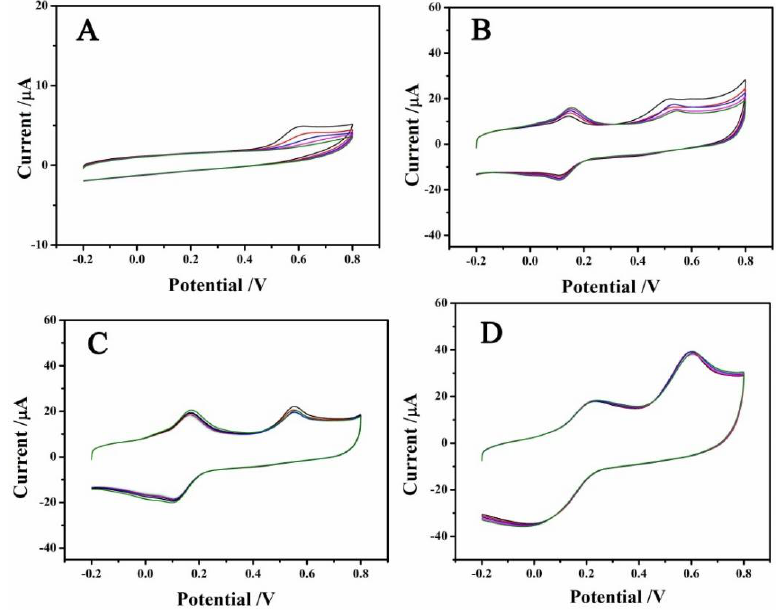
Figure 2. CVs of different electrodes for detecting BPA (0.01 mM in PBS solution, pH = 6.5) at a scan rate of 100 mV/s. ( A ) bare GCE; ( B ) rGO/GCE in the absence of phosphotungstic acid (PTA); ( C ) rGO/GCE in the presence of PTA; ( D ) MoSe 2 /rGO/GCE in the presence of PTA.